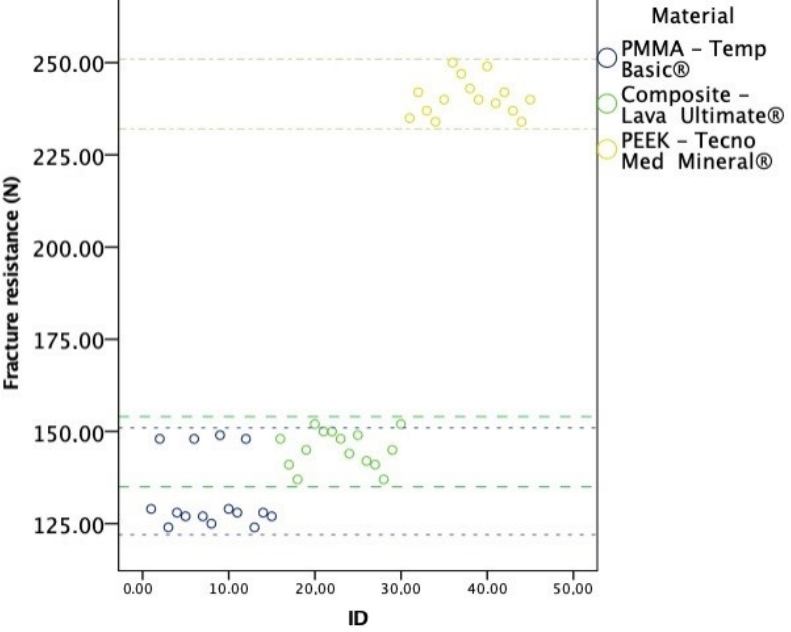
Figure 4. Distribution of all fracture strength (N) measurements.